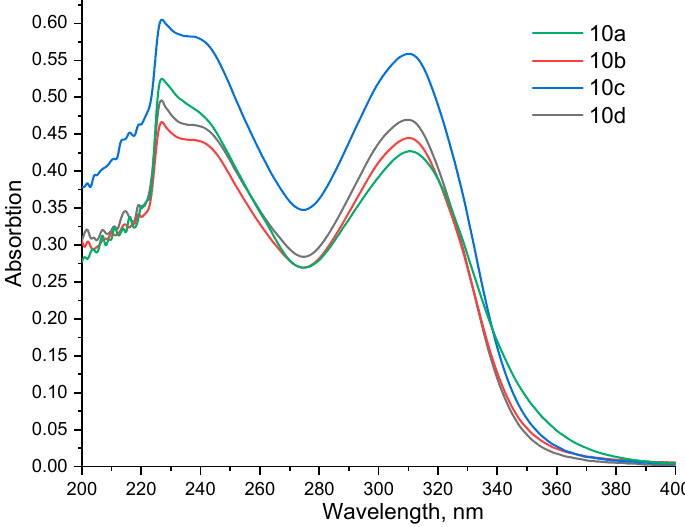
Figure 4. Absorption spectra of lanthanide (III) complexes 10 in DCM at r.t.